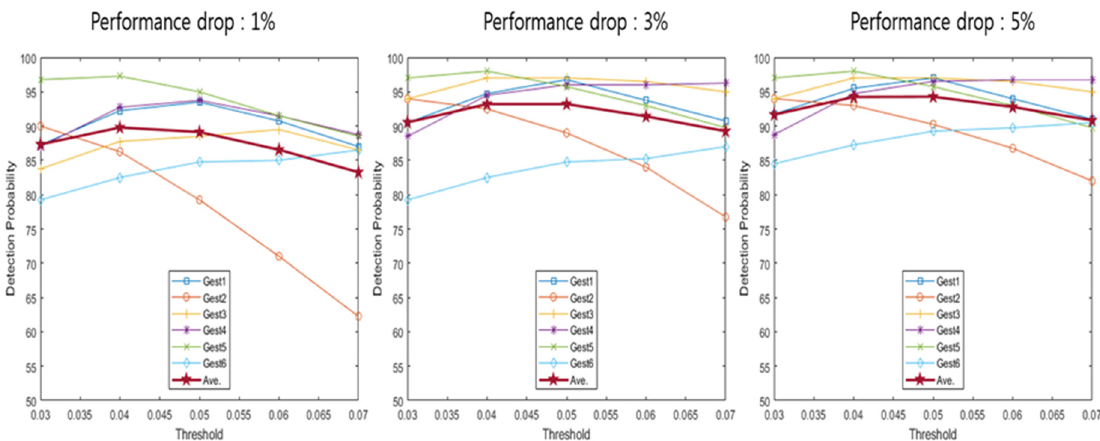
Figure 12. Detection probability of proposed method 2 (window 1).